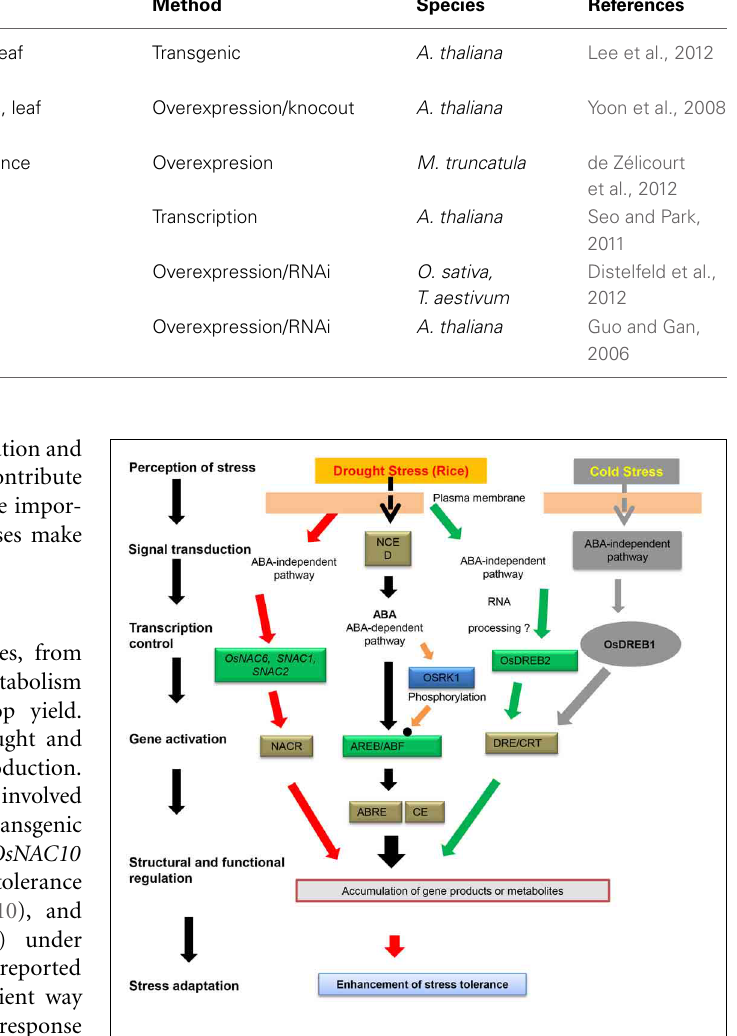
FIGURE 6 | Transcriptional regulatory networks of the cis- elements and NAC transcription factors involved in abiotic stress-induced gene expression in rice. The cis -elements involved in stress-responsive transcription are shown in white boxes. TFs controlling stress-inducible gene expression are shown in green boxes. Protein kinases involved in the phosphorylation of TFs are shown in blue boxes. The small solid black circle indicates TF modification, i.e., through phosphorylation, in response to stress